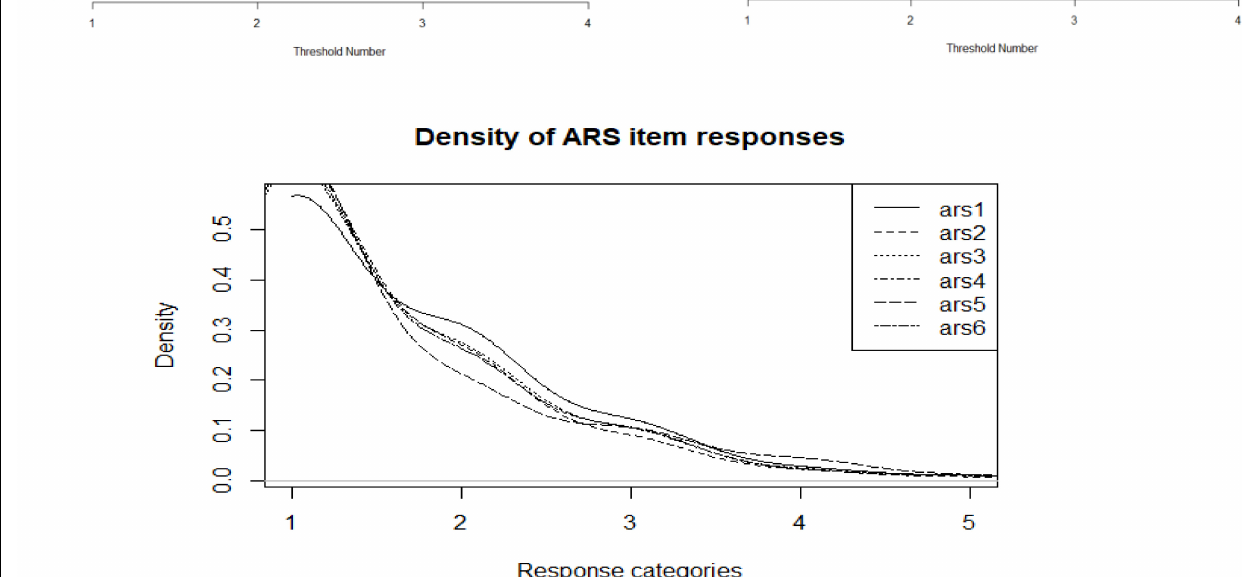
Frontiers in Psychology |